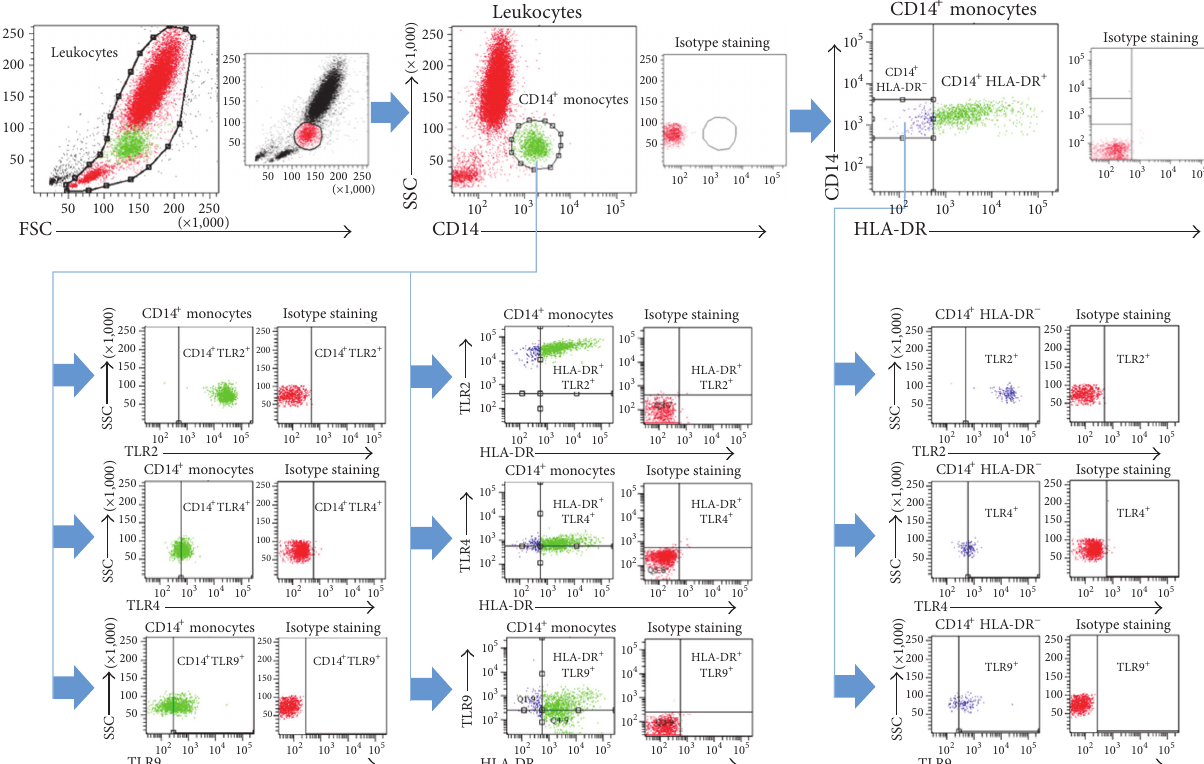
Figure 1: Gating strategy for the flow cytometric analysis and